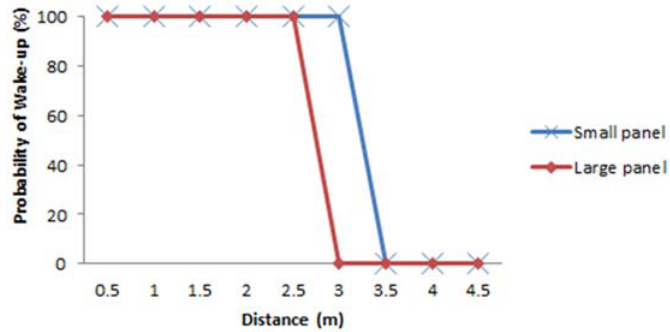
Figure 17. Probability of wake-up vs. distance for small and large indoor solar panels, under interference from fluorescent light with correlator setting ON.